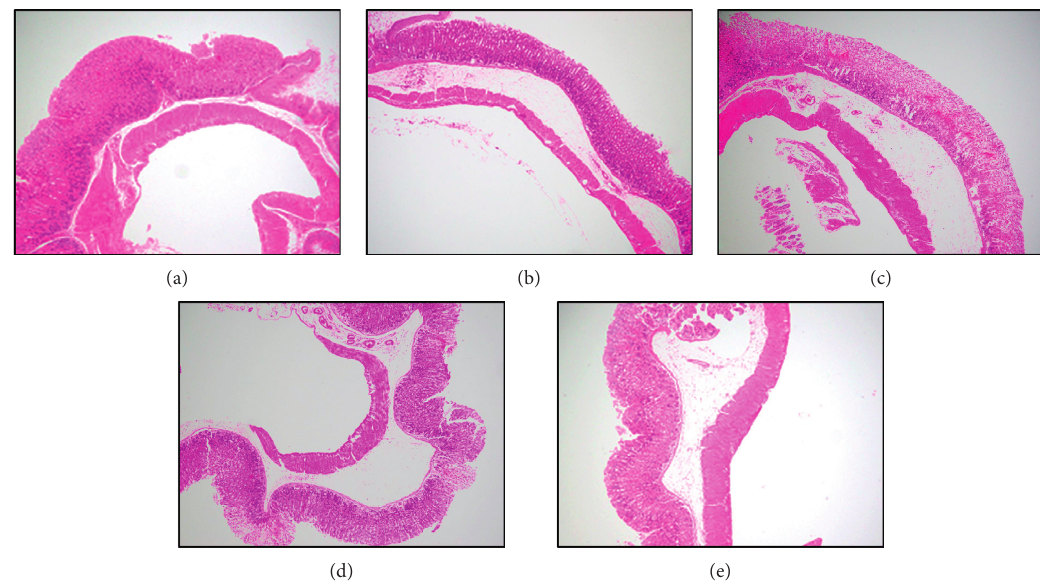
Figure 3: Pathological observation of gastric injury in mice with gastric injury. Ranitidine group: 50mg/kg b.w. ranitidine treatment dose; LLTP group: 100mg/kg b.w. Liupao tea polyphenols dose; and HLTP group: 200mg/kg b.w. Liupao tea polyphenols dose. (a) Normal. (b) Model. (c) Ranitidine. (d) LLTP. (e) HLTP. Table 5: SOD, GSH, and MDA levels in serum of mice with gastric injury.